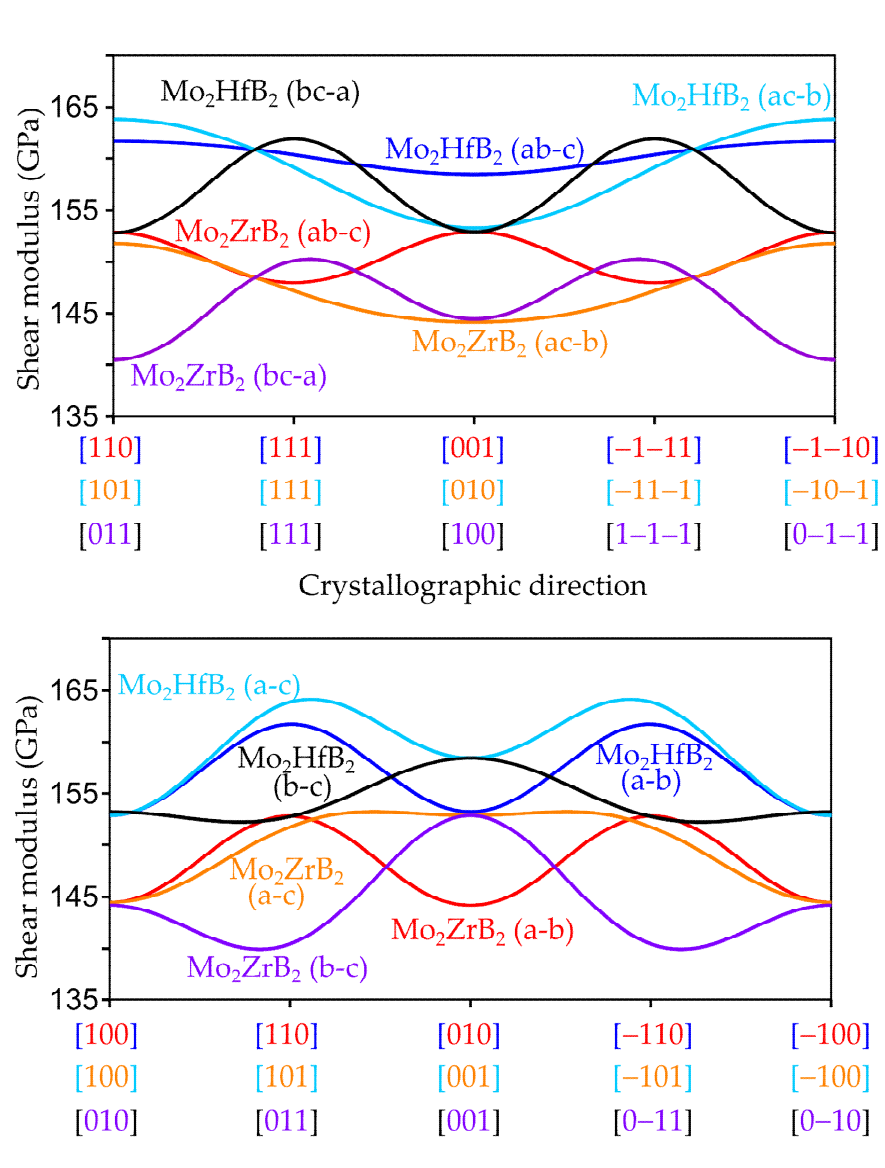
Figure 5. Anisotropic shear modulus in the a - b , a - c and b - c -plane ( lower part ) and the ab - c , ac - b and bc - a -plane ( upper part ) of Mo 2 ZrB 2 (red, orange and purple) and Mo 2 HfB 2 (blue, cyan and black), respectively, both with the AlMn 2 B 2 -type respectively, both with the AlMn 2 B 2 -type structure.